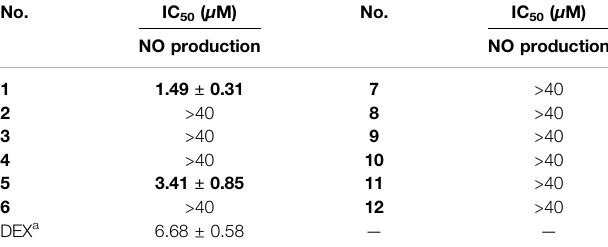
TABLE 3 | Inhibitory activity against LPS-induced NO production of 1 – 12